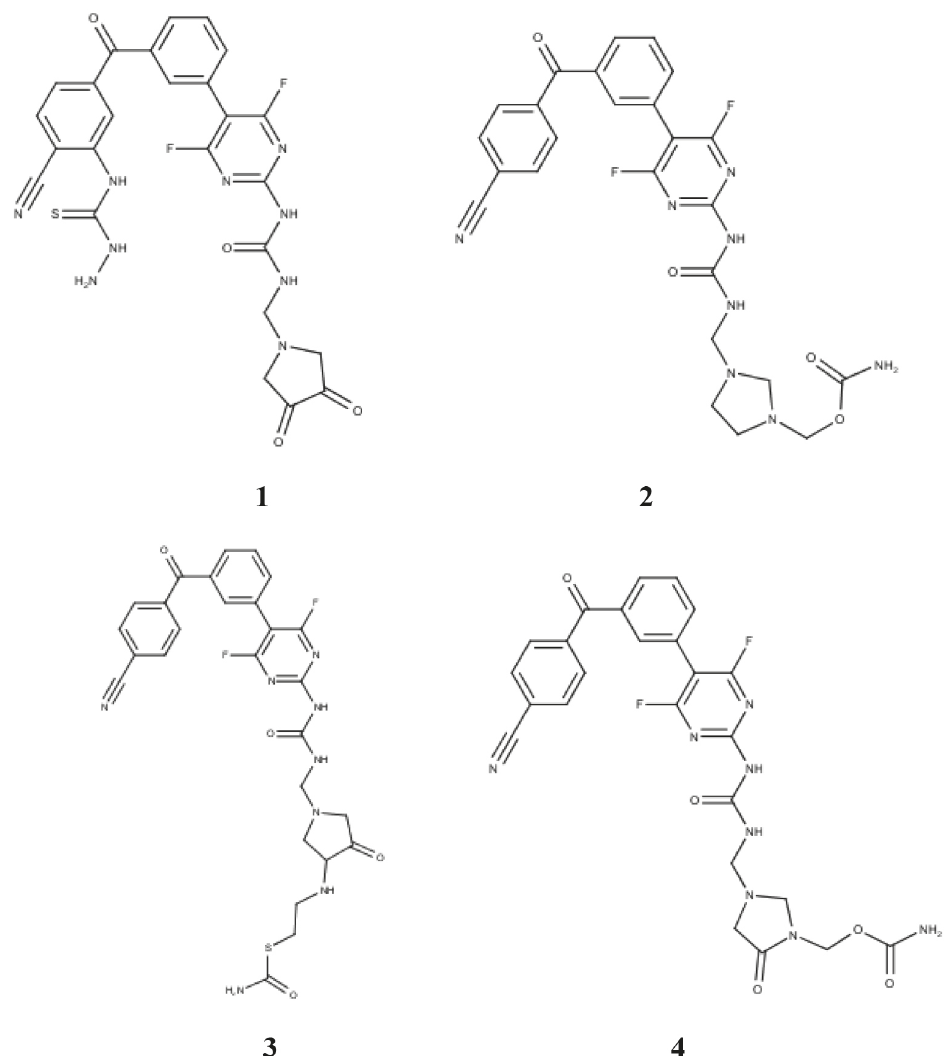
FIGURE 22 - Four best molecules suggested as possible versatile anti-HIV agents (MTI-2 to MTI-5, numbered 1–4,